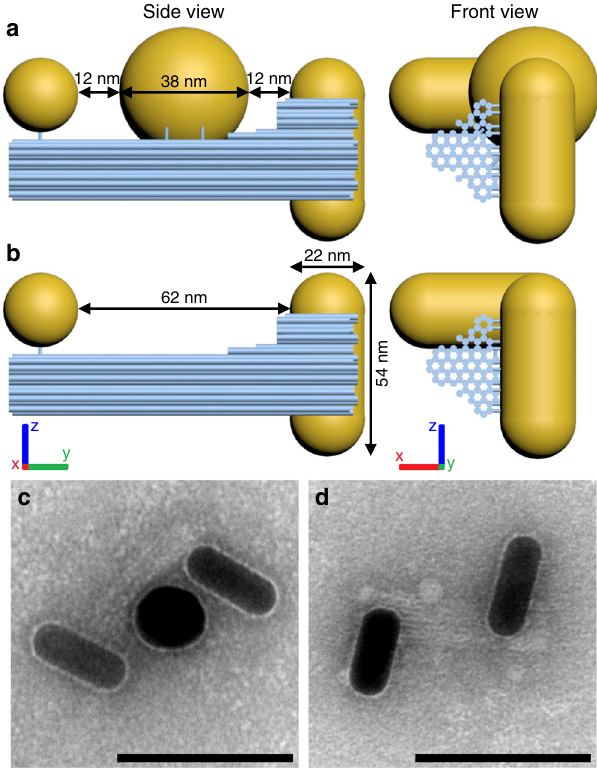
Fig. 1 Chiral plasmonic transmitter. a Side view and front view of DNA origami-nanoparticle assemblies in a nanorod – nanosphere – nanorod (NR – NS – NR) arrangement and b a nanorod – void – nanorod (NR – – NR) arrangement. The nanorods and the nanosphere are mounted on a DNA origami structure (blue cylinders represent DNA helices) via thiolated DNA strands that are anchored to the origami structure. c Transmission electron micrograph of assemblies in the NR – NS – NR arrangement and d in the NR – – NR arrangement. Scale bars: 100